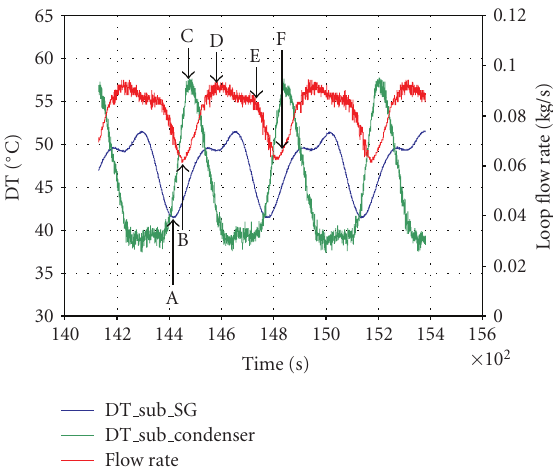
Figure 9: Low-frequency oscillations: steam generator inlet sub- cooling, pool condenser outlet subcooling, and loop flowrate as a function of time (Data obtained with power = 23kW − FR = 0.79- with heat losses compensation).